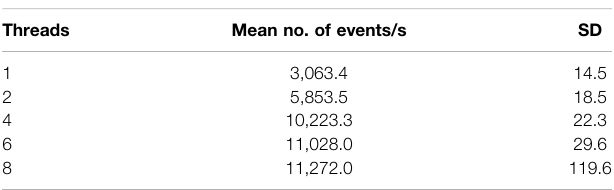
TABLE 2 | Data points given in Figure 3